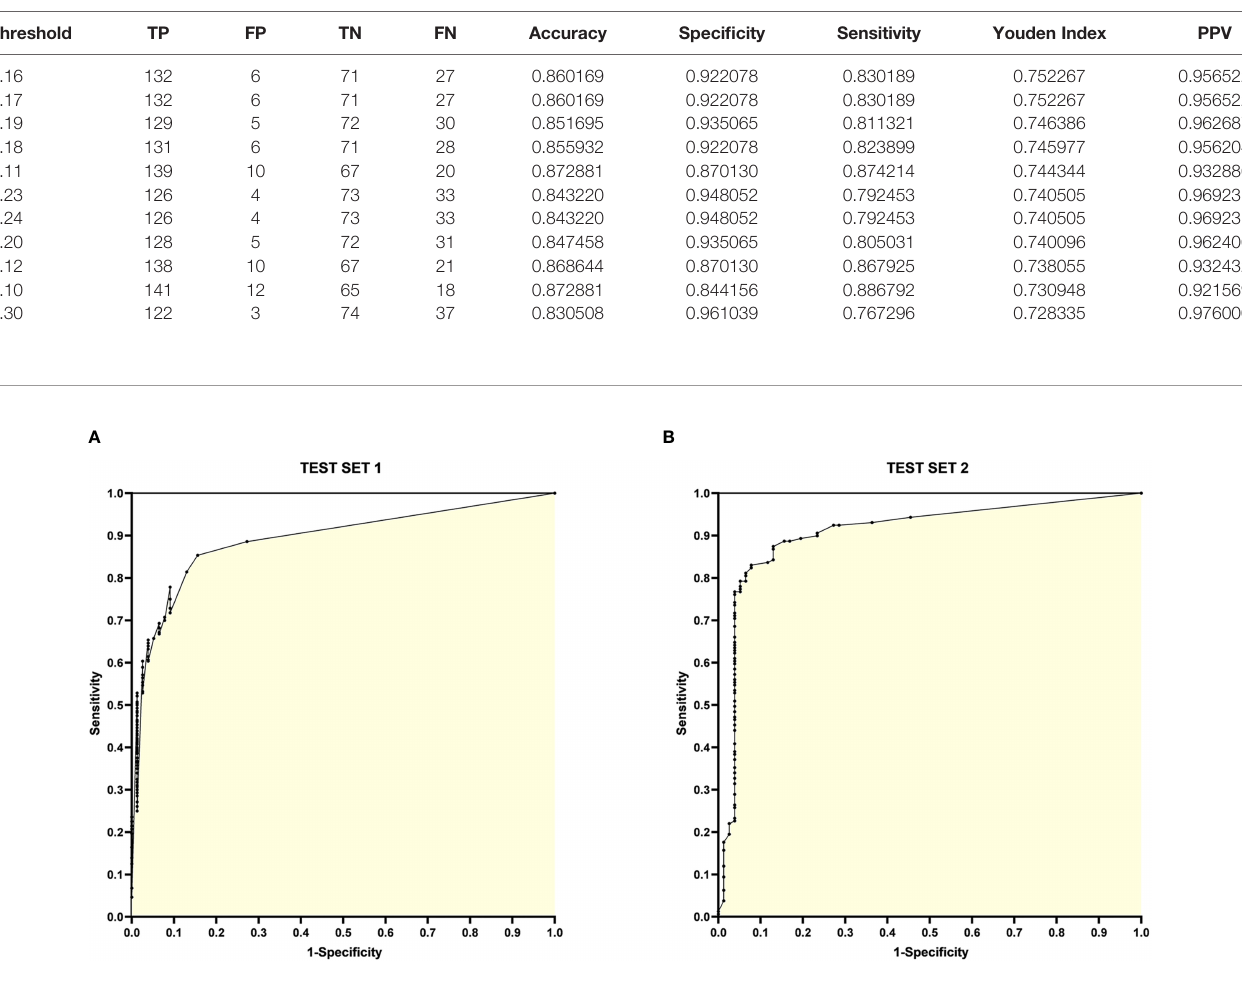
FIGURE 4 | ROC curves for Test Set 1 and 2. (A) ROC curve for Test Set 1, with the horizontal coordinate 1-speci fi city and the vertical coordinate sensitivity, the AUC is 0.8925; (B) ROC curve for Test Set 2, with the horizontal coordinate 1-speci fi city and the vertical coordinate sensitivity, the AUC is